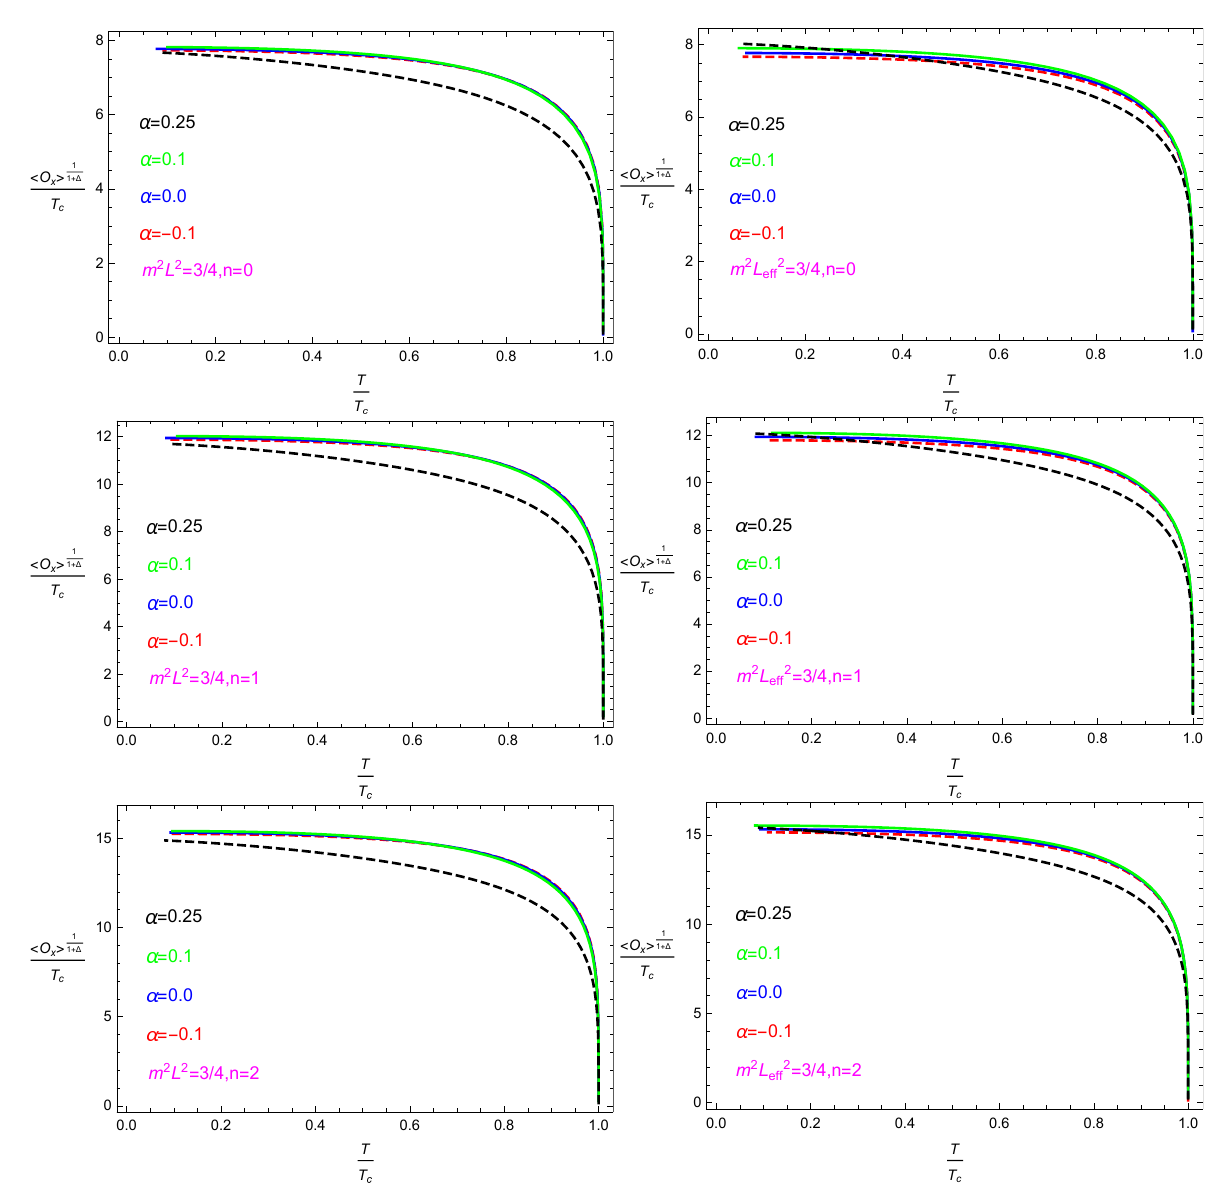
Figure 1. (Color online) The condensates of the vector operator O x as a function of temperature for = 3/4 ( right ) with different values of the the masses of the vector field m 2 L 2 = 3/4 ( left ) and m 2 L 2 eff Gauss–Bonnet parameter from the ground state to the second excited state. In each panel, the four lines correspond to increasing Gauss–Bonnet parameters, i.e., α = − 0.1 (red and dashed), 0.0 (blue), 0.1 (green), and 0.25 (black and dashed),